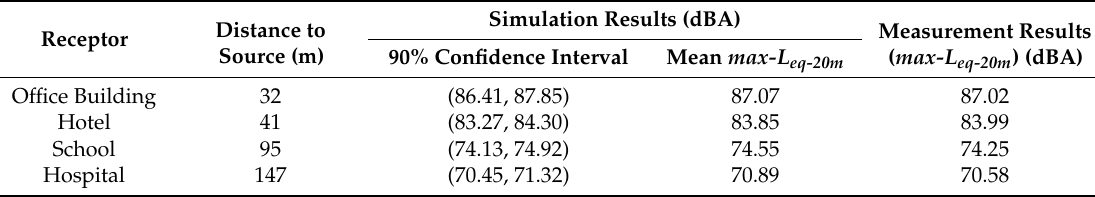
Table 3. Comparison between simulation results and measurement